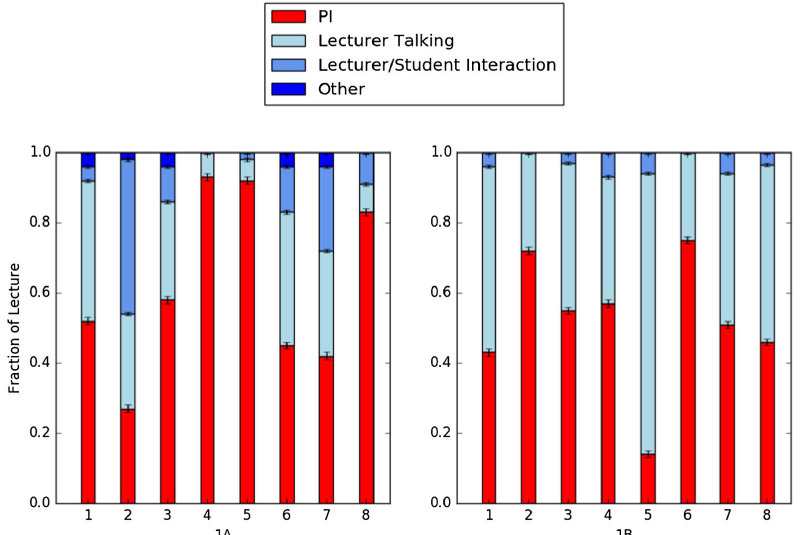
FIG. 3. Fractional time spent on Peer Instruction. [Note that Peer Instruction consists of both interactive (38% for 1A and 33% for 1B), vicarious interactive and passive